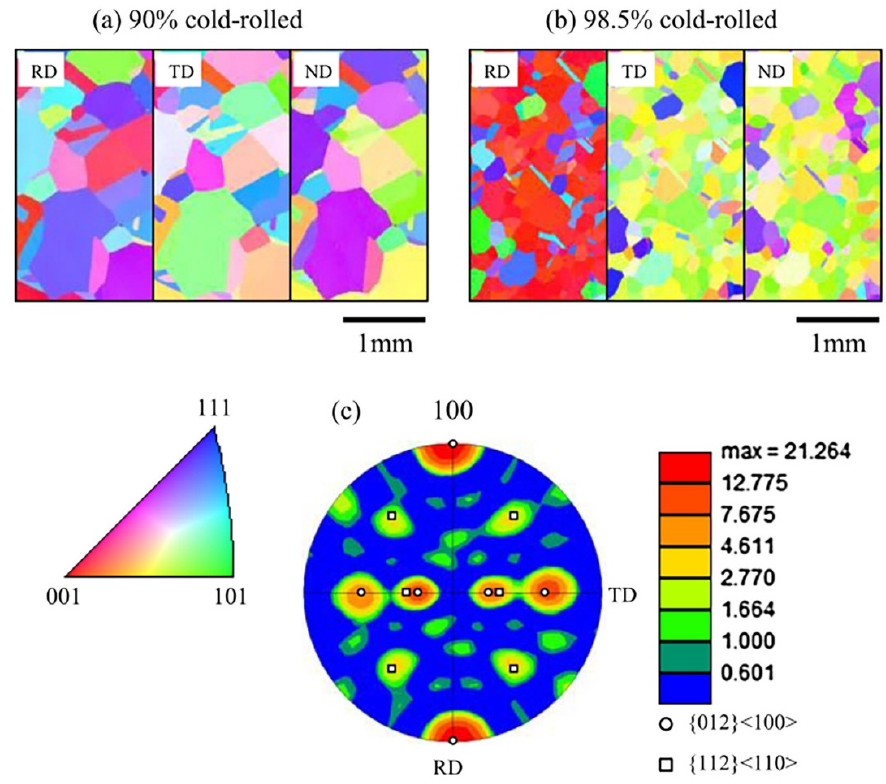
Figure 15. FeNiCoAlTiB alloy quasi-colored orientation maps in rolling direction (RD), transverse direction (TD) and normal direction (ND): ( a ) 90% cold-rolling; ( b ) 98.5% cold-rolling; ( c ) (100) pole figure in 98.5% cold-rolling specimen [69]. Reprinted with permission from Ref. [69]. Copyright 2014 Elsevier.